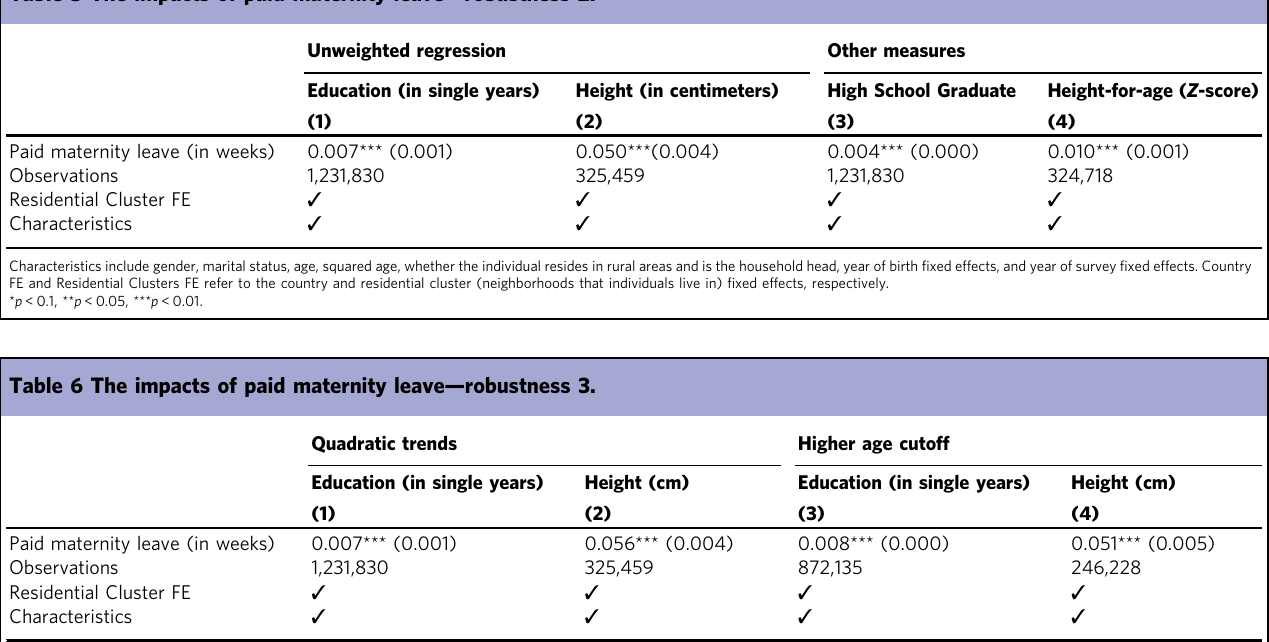
Table 5 The impacts of paid maternity leave — robustness